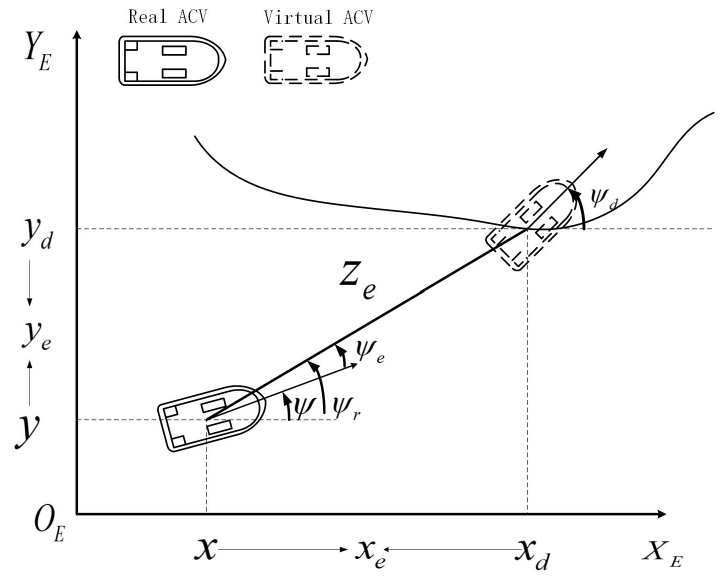
Figure 3. Tracking errors.